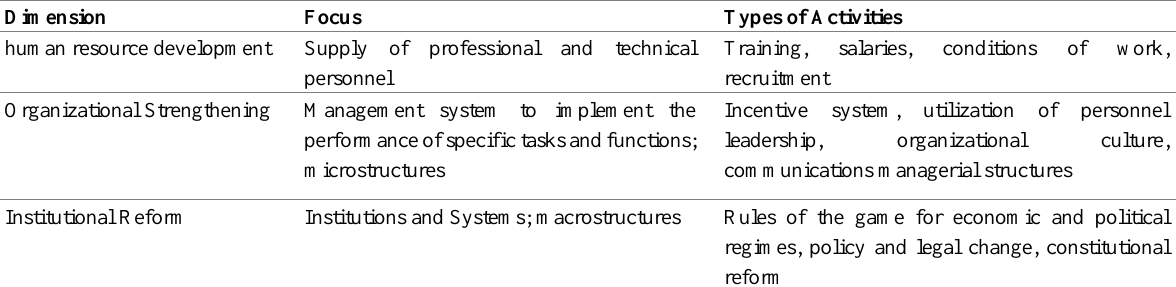
Table 1: Table of dimensions and focus of capacity building Grindle and Merilee